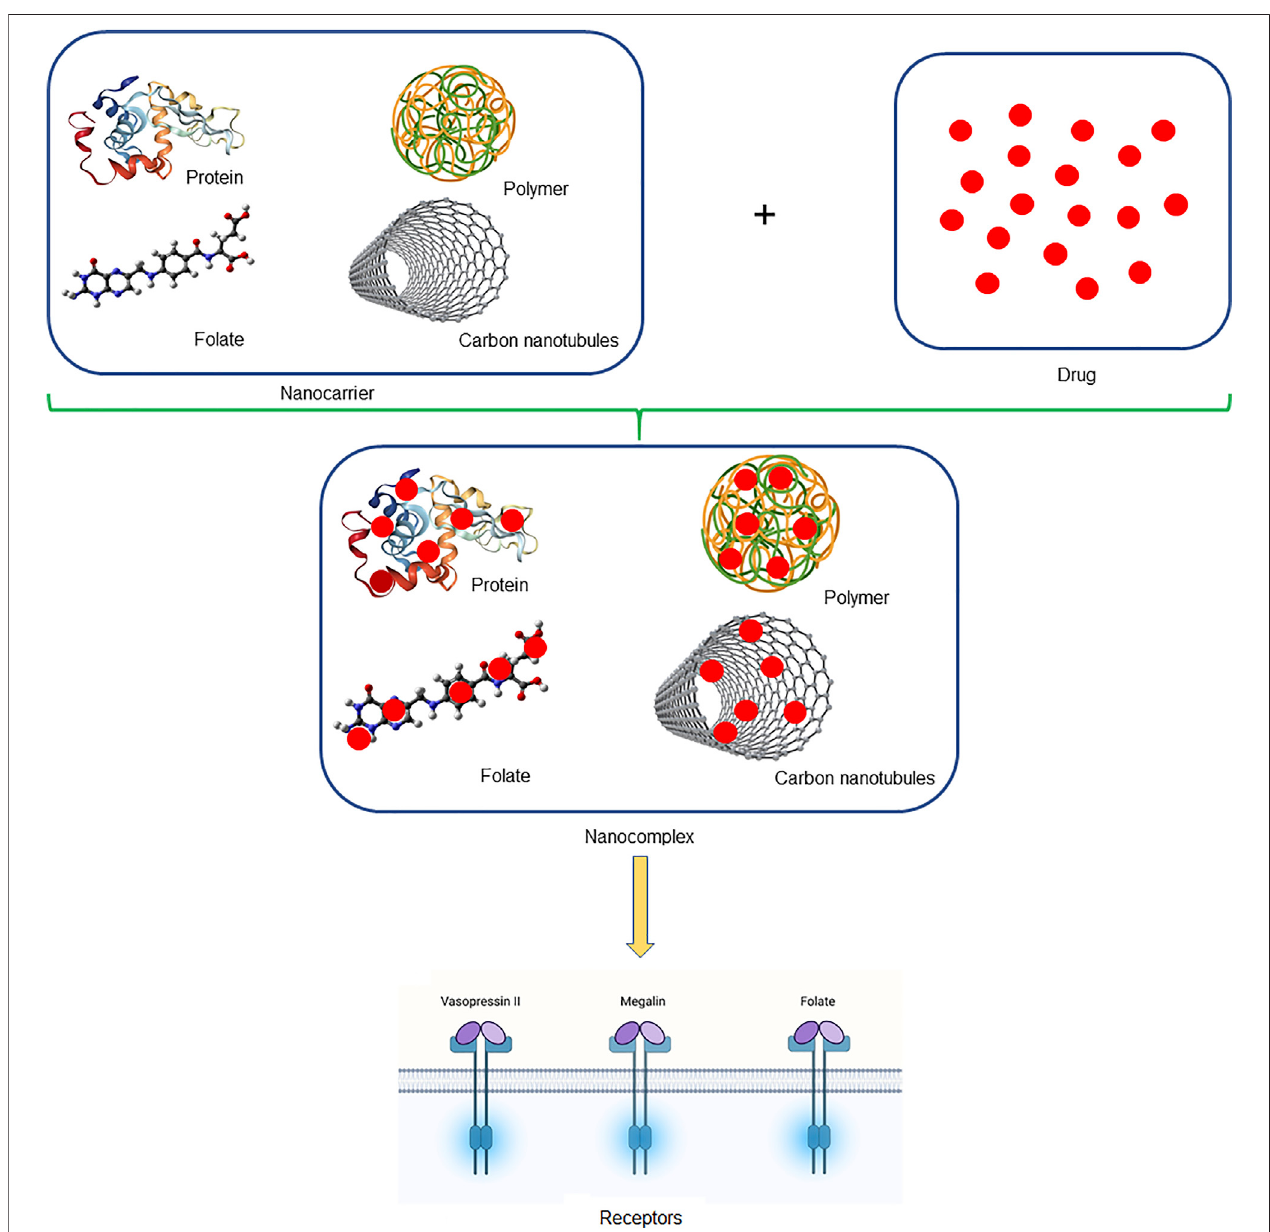
FIGURE1| Schematicillustrationofnanocomplex.The fi gurementionedbrie fl ythenanocarrierswhichwereusedtocarrydrugsintheformofnanocomplex,which tends to deliver drugs safely to the kidney.